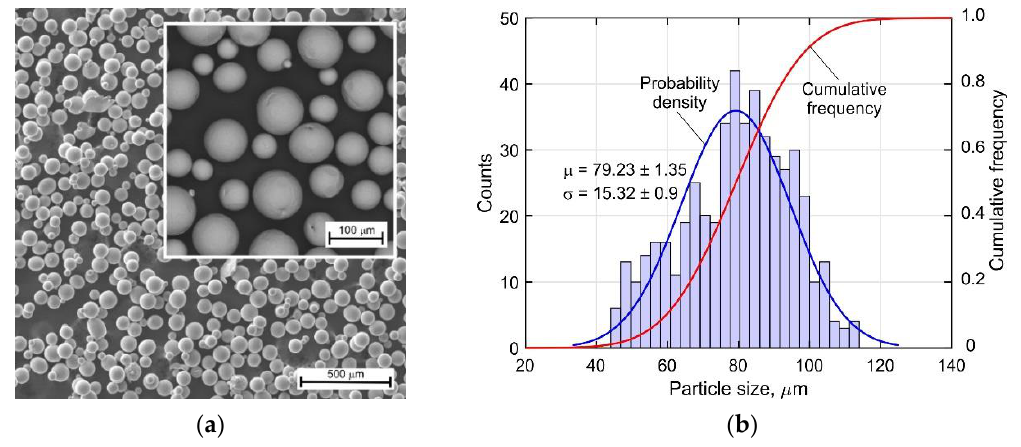
Figure 2. ( a ) Scanning electron micrograph of Ti-6Al-4V powder and ( b ) size distribution of the powder